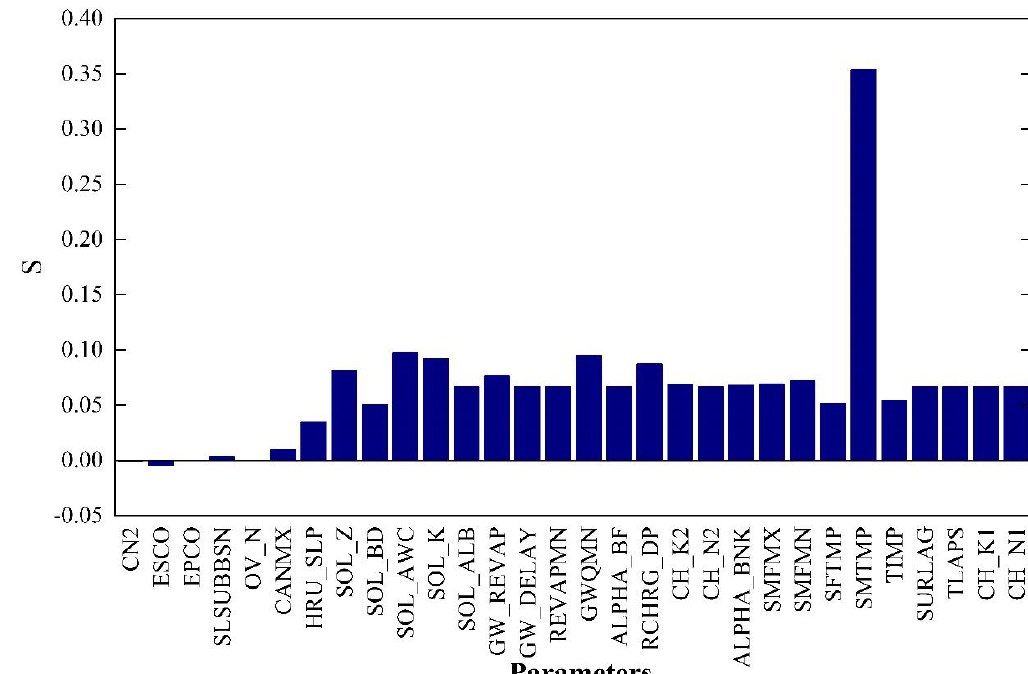
Figure 8. Total sensitivity ( 𝑆 𝑇 ) of each parameter of Sobol analysis. According to the total sensitivity ( 𝑆 𝑇 ) and first-order sensitivity ( 𝑆 ), the interaction effect ( 𝐼𝐸 ) was calculated as shown in Table 2. Among all the parameters, SMTMP and SFTMP had apparent interaction effects, suggesting that the interaction between these two and other parameters except themselves noticeably impacted the model results. The in- teraction effect ( 𝐼𝐸 ) of parameters CANMX, CN2, EPCO, OV_N, and SLSUBBSN was